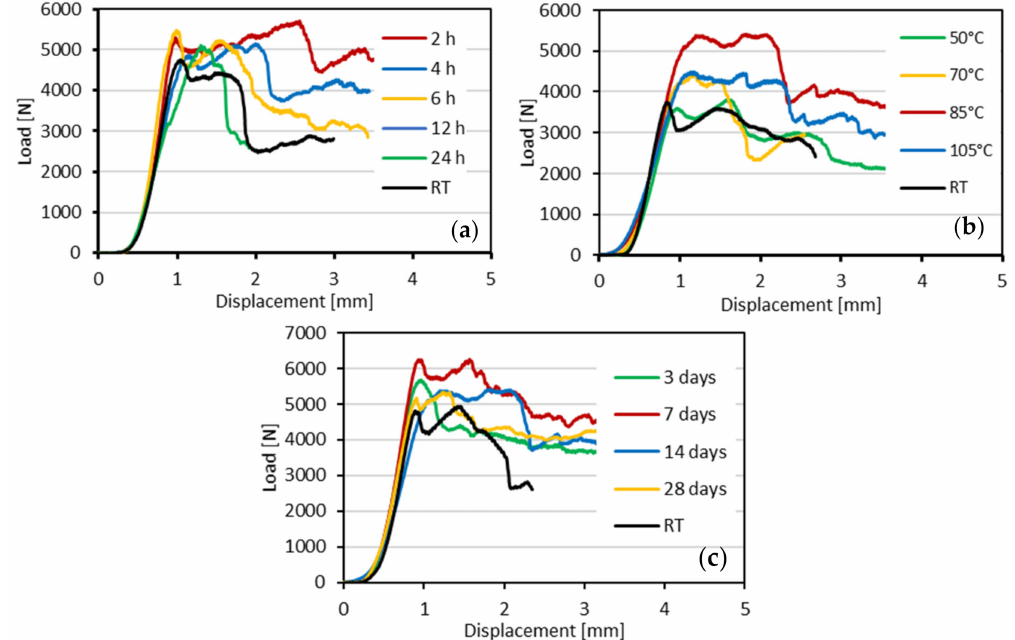
Figure 5. Flexural load–displacement behavior of GF under different conditions: ( a ) at 85 ◦ C for 2, 4, 6, 12, 24 and RT after 28 days, ( b ) at 50, 70, 85 and 105 ◦ C and RT for 2 h after 7 days, ( c ) at 85 ◦ C for 2 h after 3, 7, 14 and 28